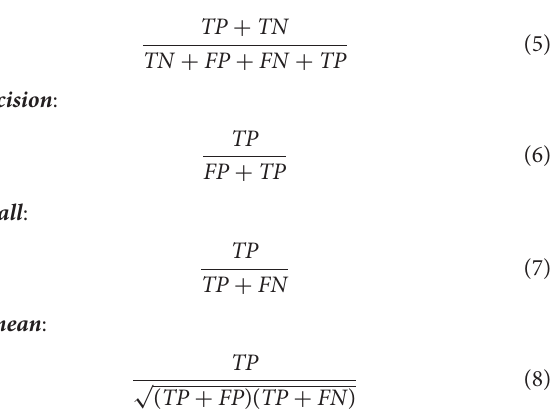
Supplementary Figure 1 . The Bag-of-Unique-Descriptors of the six virus classes, SARS-CoV-1, MERS-CoV, SARS-CoV-2, Ebola, Dengue, and Influenza are shown in Figures 4E–J for k